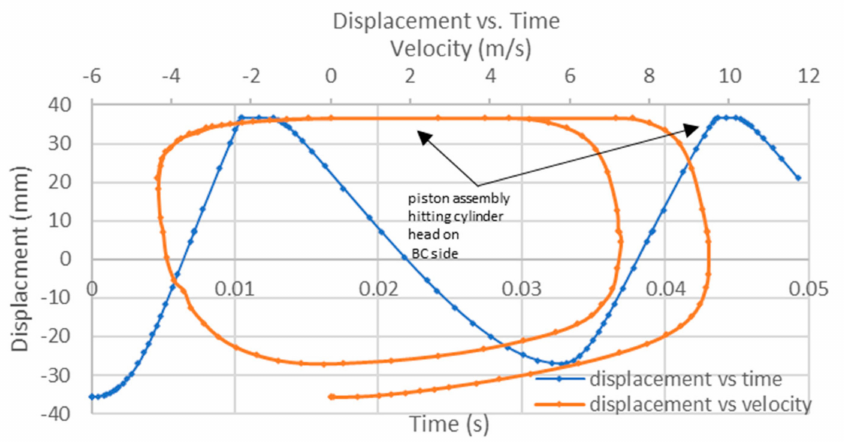
Figure 4. Piston assembly hitting BC cylinder head for larger combustion pressure in